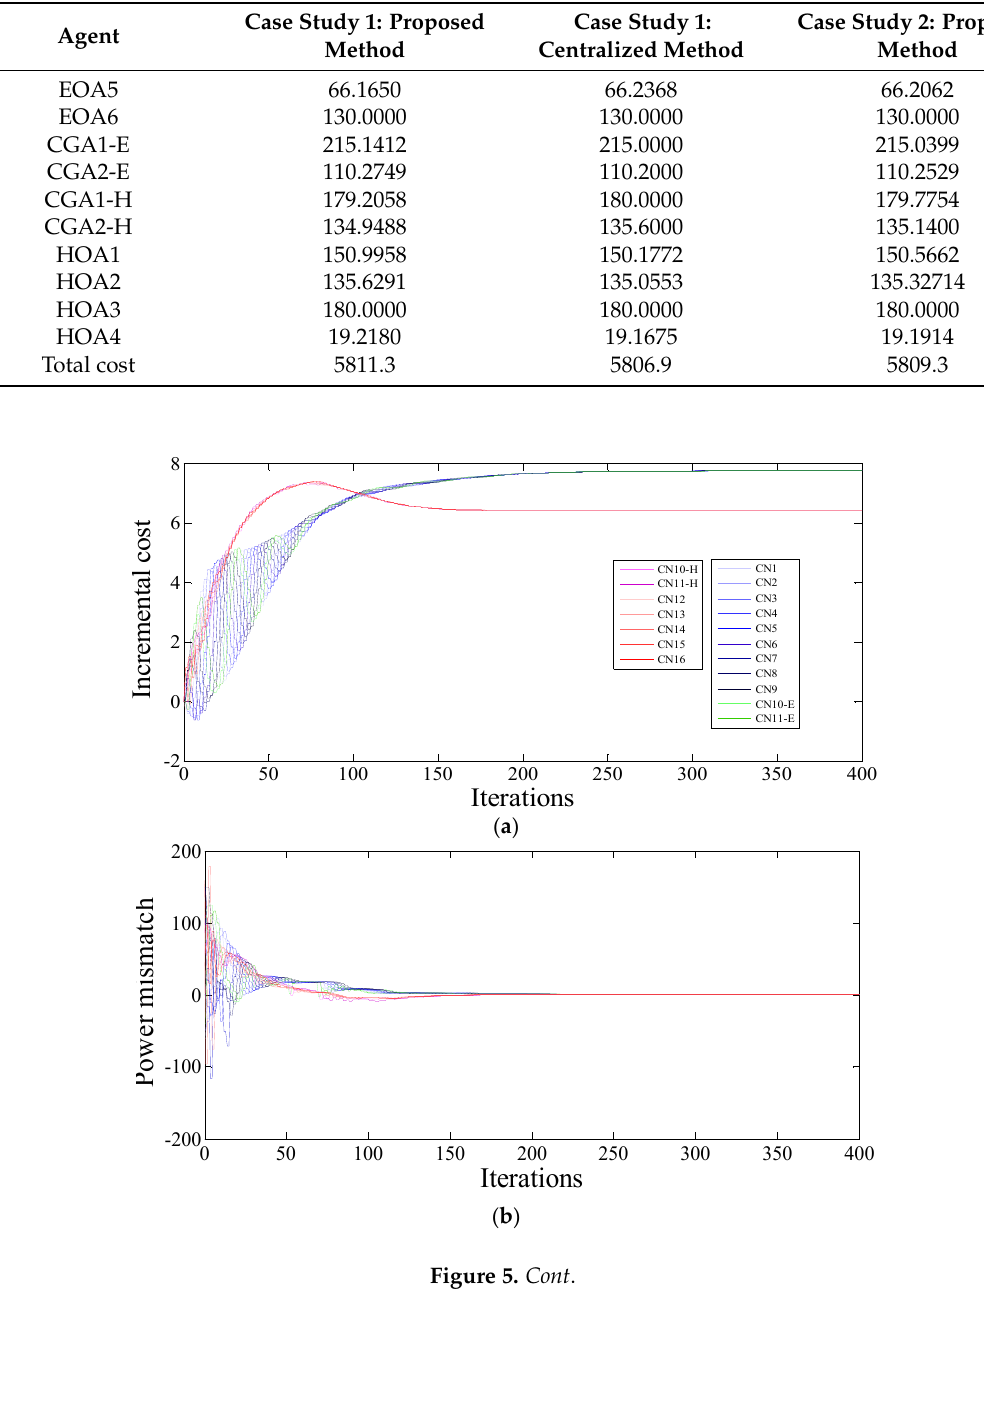
Table 2. Comparison for the 16 ‐ bus system.